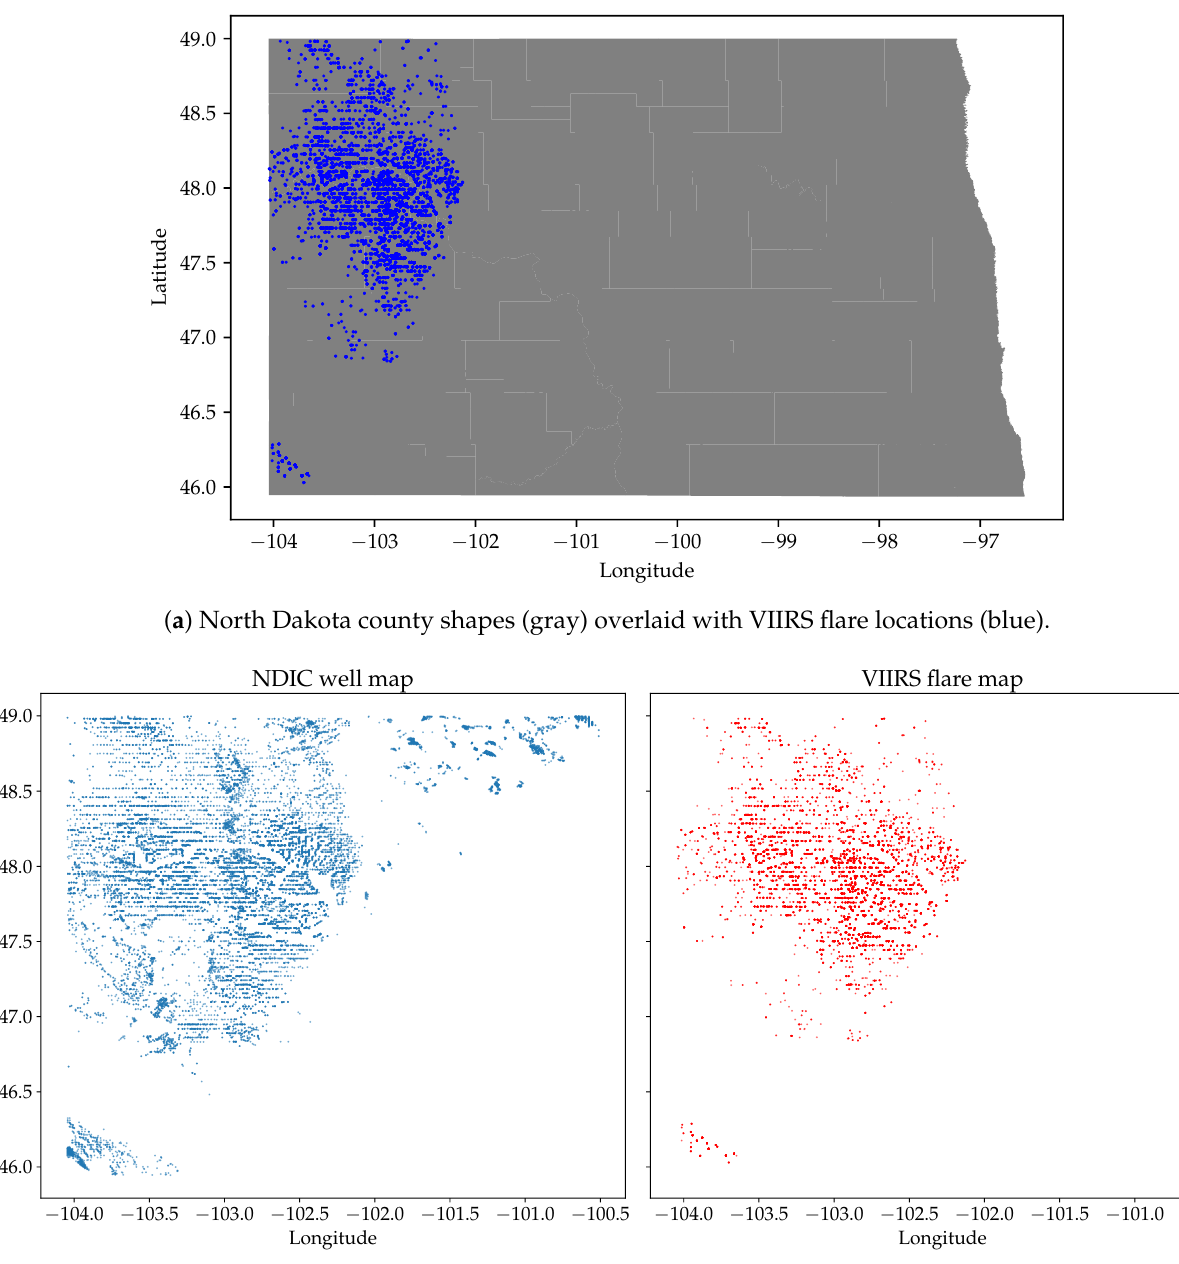
Figure 3. Location maps illustrating the study